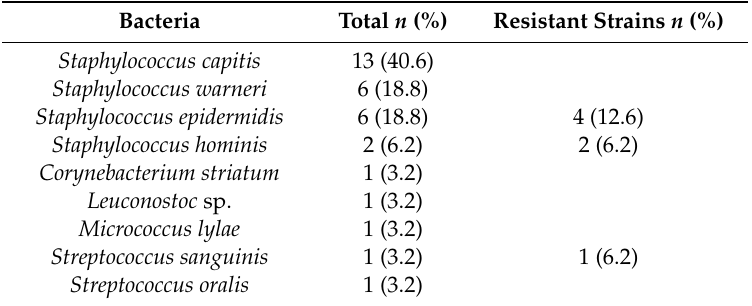
Table 1. Bacterial strains identified from 32 pillbox samples upon return from medical units. Bacteria